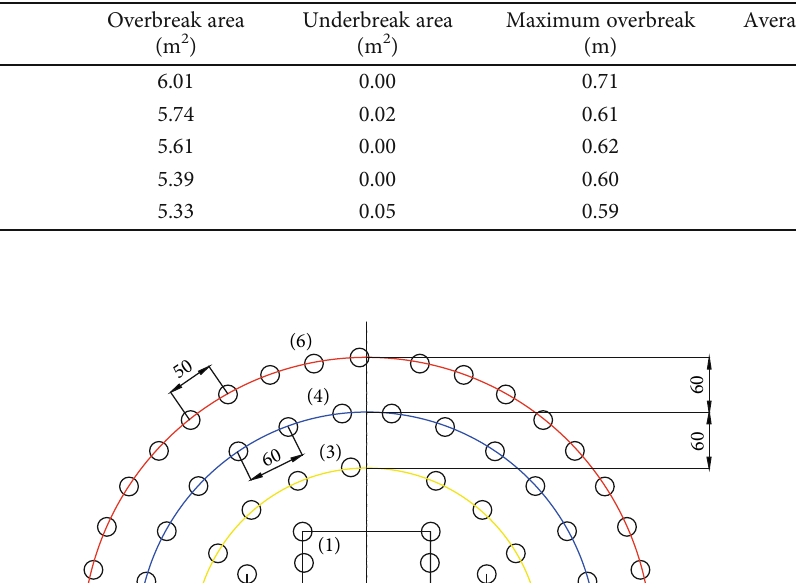
Table 4: Index values of tunnel smooth blasting before implementation.